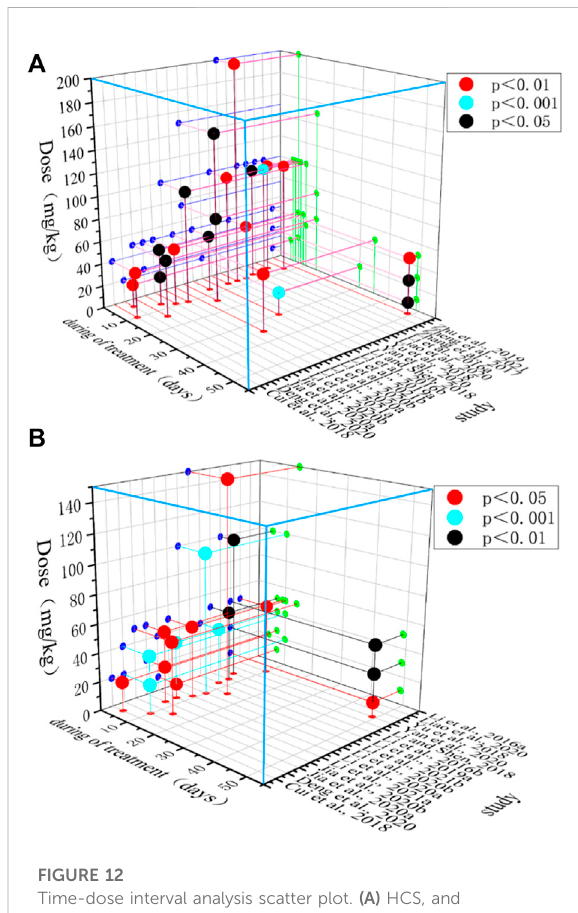
FIGURE 12 Time-dose interval analysis scatter plot. (A) HCS, and (B)